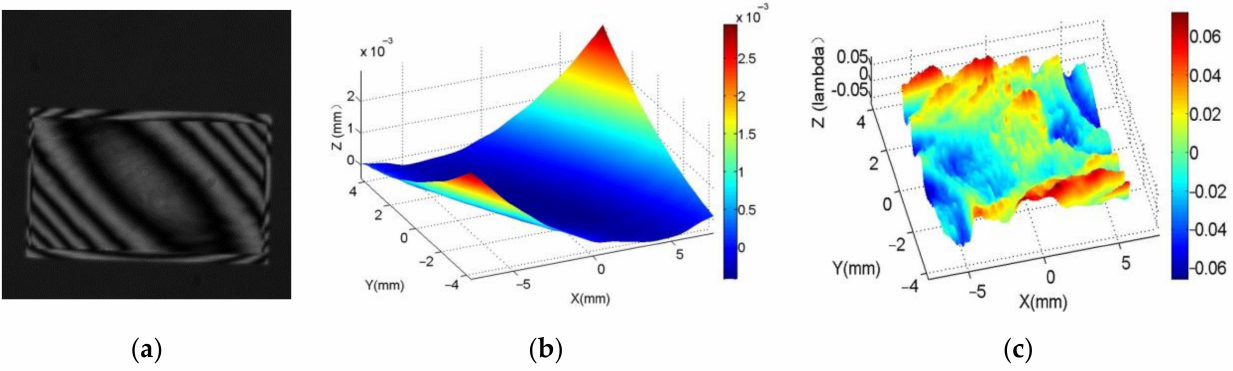
Figure 18. The freeform generated by LCoS-SLM and its deviation. ( a ) the interferogram ( b ) the OPD data ( c ) the wavefront